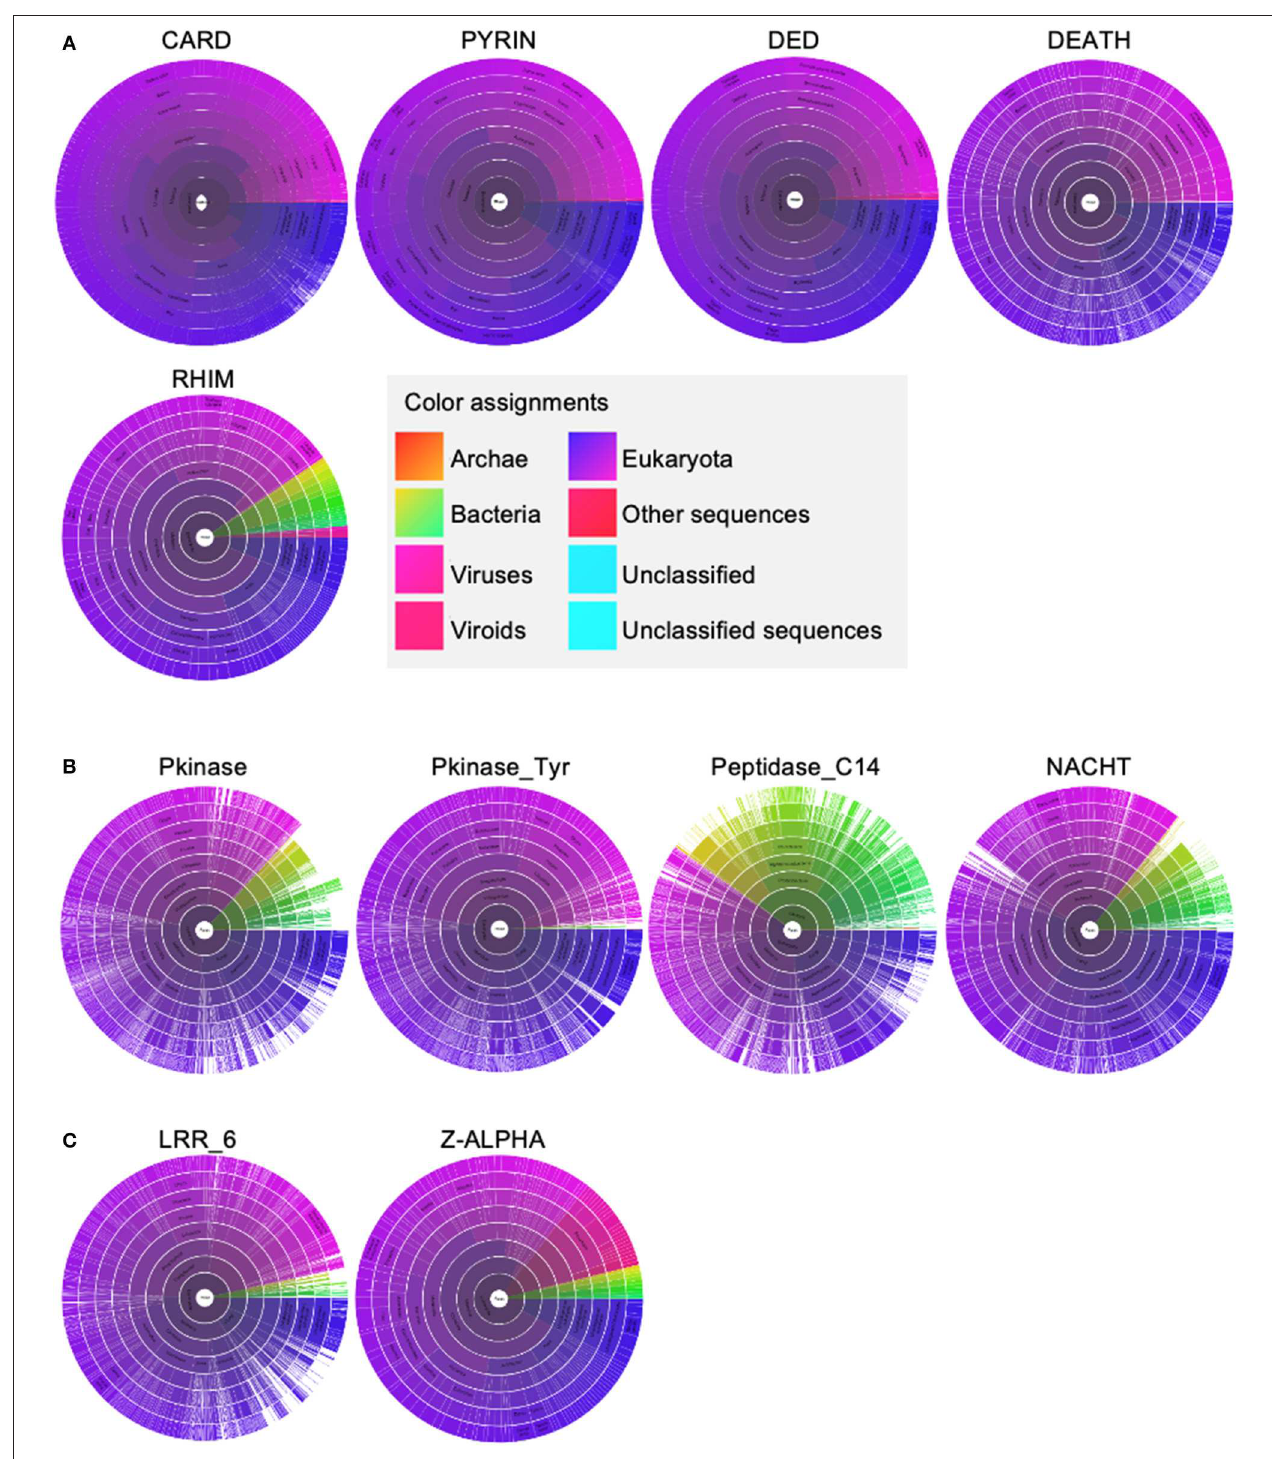
FIGURE 2 | The distribution of molecular motifs present in PANoptosome components. (A) Distribution of assembly domains. (B) Distribution of catalytic domains. (C) Distribution of sensing domains. All domain names and their distributions were obtained from the Pfam database (Sonnhammer et al., 1997). Sunburst visualizations and color assignment legends were exported from the Pfam